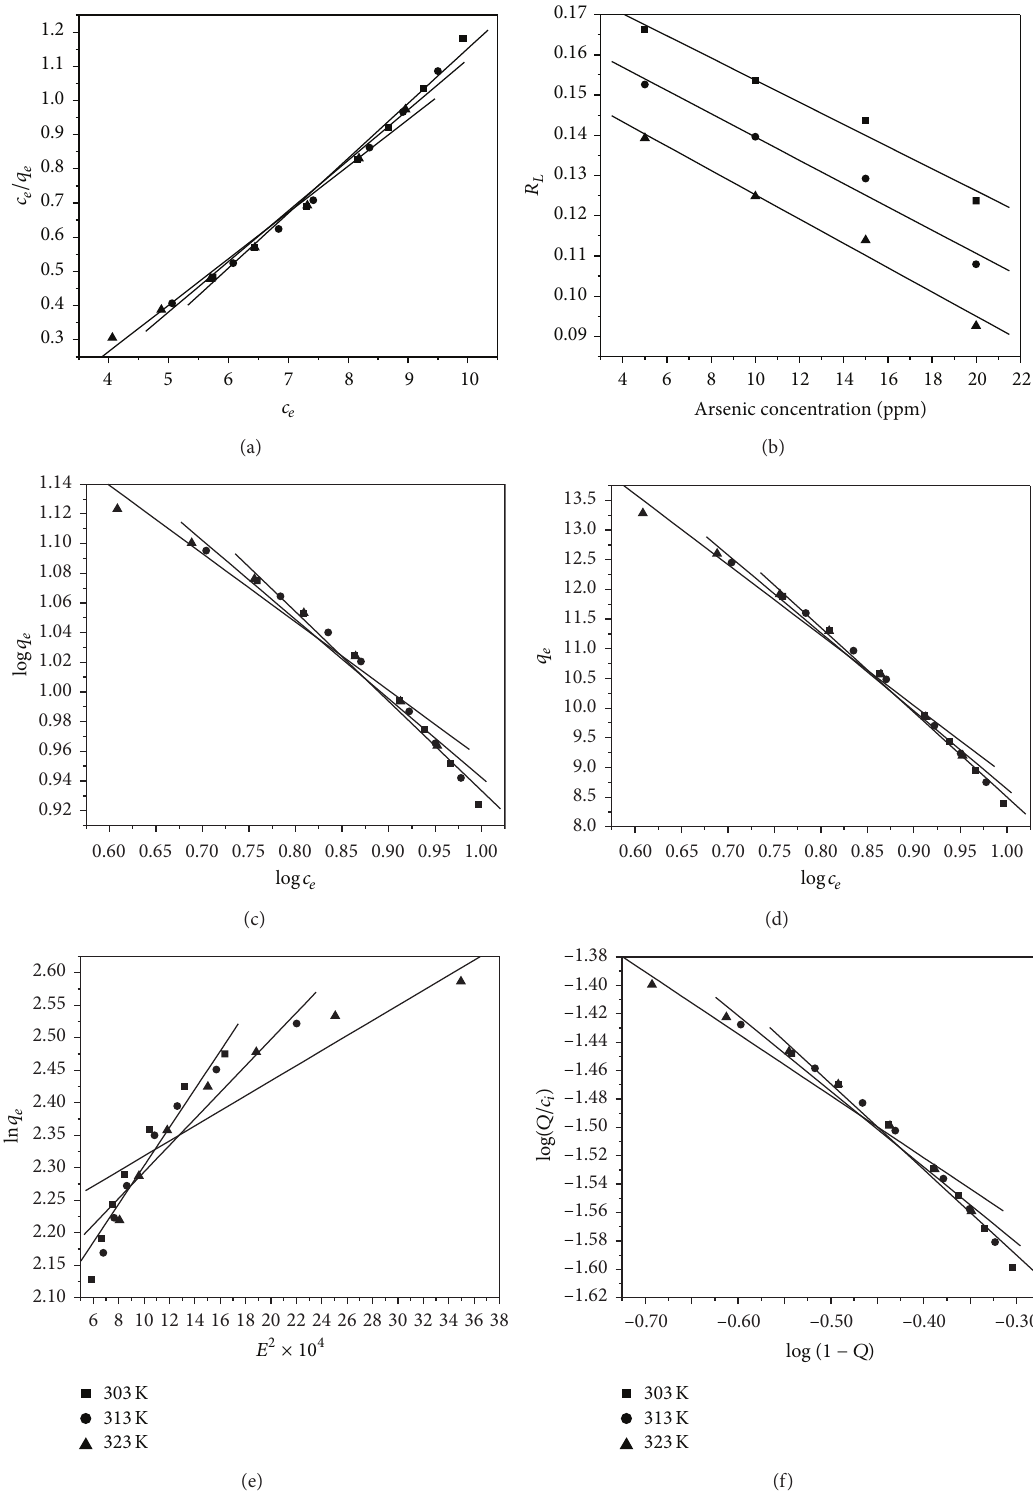
Figure 4: (a) Plot of the Langmuir isotherm for arsenic biosorption onto Moringa oleifera . (b) Separation factor 𝑅 𝐿 values verses initial arsenic concentration for various temperatures derived by Langmuir constants. (c) Plot of the Freundlich isotherm for arsenic biosorption onto Moringa oleifera . (d) Plot of the Temkin isotherm for arsenic biosorption onto Moringa oleifera . (e) Plot of the D-R isotherm for arsenic biosorption onto Moringa oleifera . (f) Plot of the F-H isotherm for arsenic biosorption onto Moringa oleifera